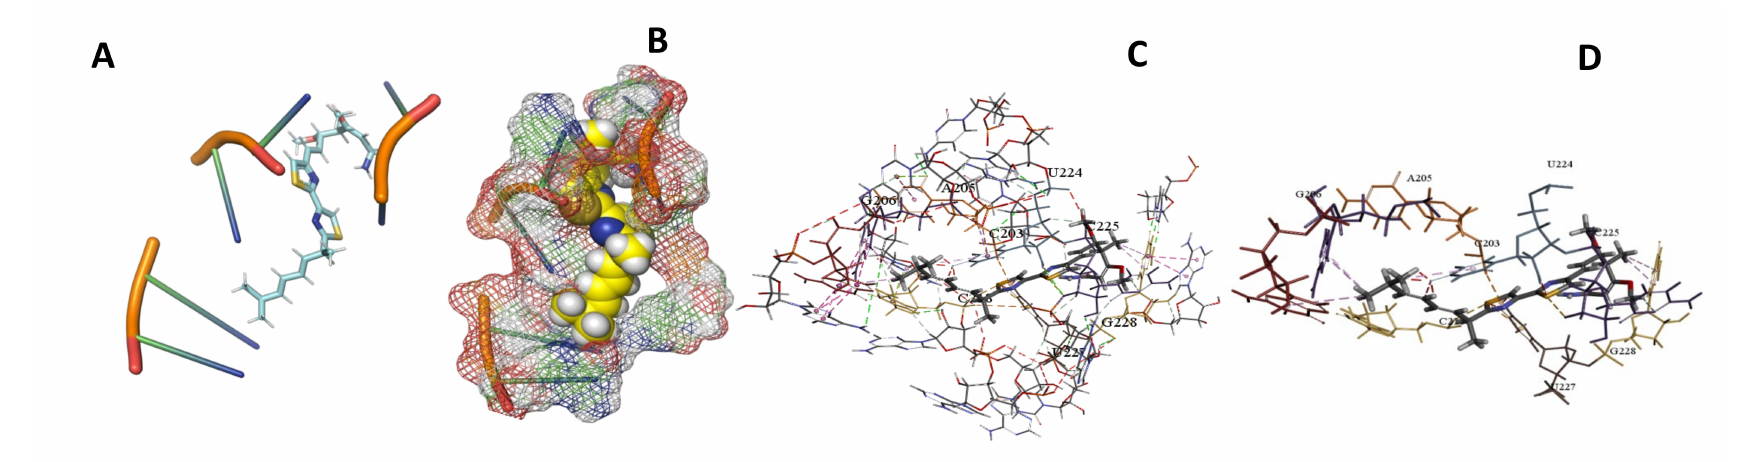
Figure 27. L. Major + Myxothiazol. ( A ): Best binding pose and nucleotides involved. ( B ): Schematic binding pocket. ( C ): shows the Nucleotides component that re involved in binding. ( D ): Shows the main bonds involved between the compound and the nucleotide